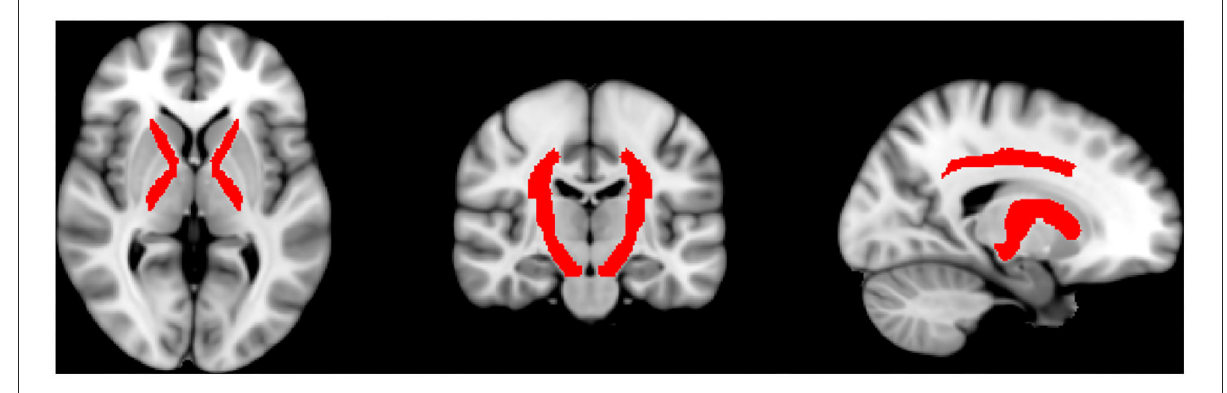
FIGURE1 Shown are the automatically drawn ROIs that correspond to sensory tracts by using the DTI-81 Atlas in the FMRIB library package.